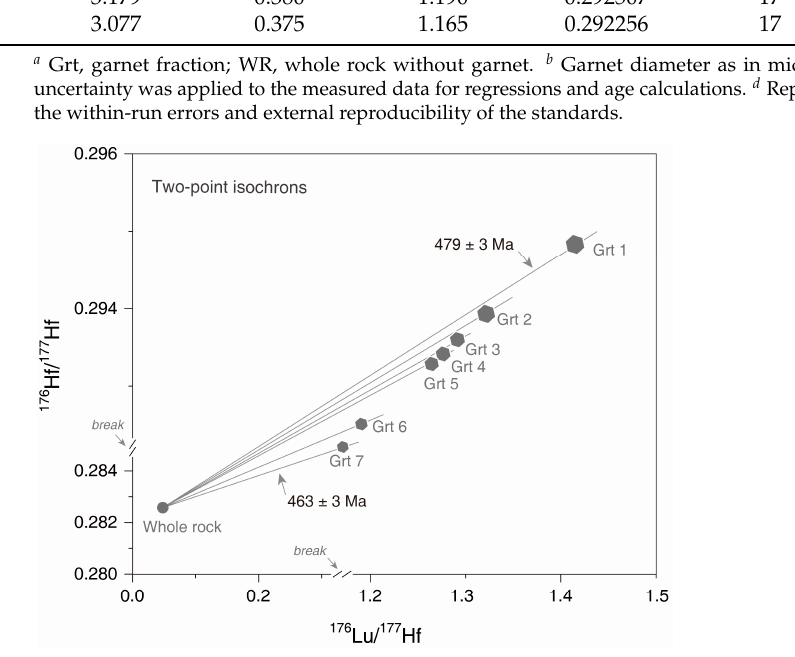
Figure 3. Lu–Hf isochron diagram for seven garnet and whole-rock aliquots. Two breaks are set in the X -axis and Y -axis to amplify the differences between the garnet fractions. The size of the symbols is significantly larger than the error bars.